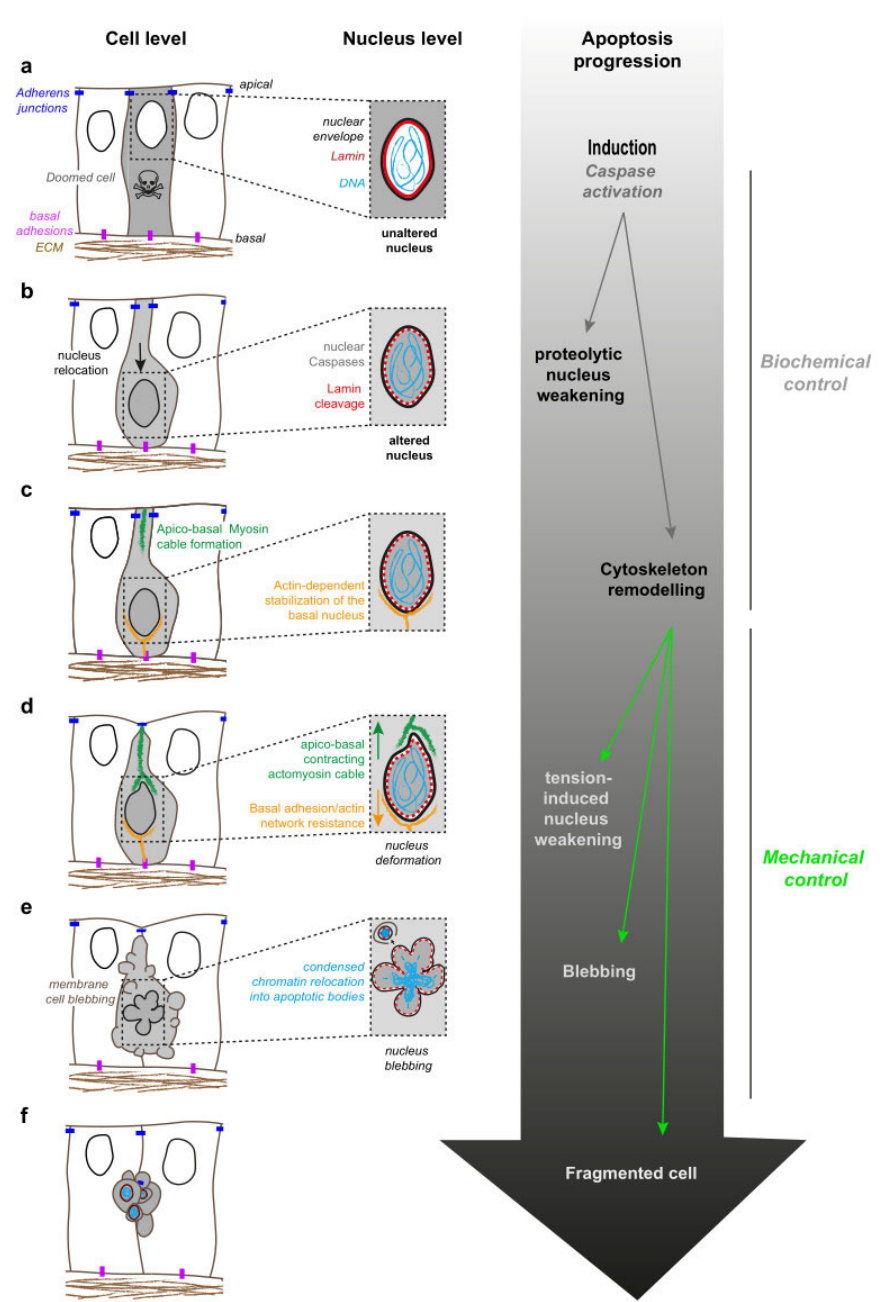
Figure 2. A model of biochemical and mechanical cooperation during apoptotic nucleus dismantling. Schematic representation of cell and nucleus dynamics (left and middle columns, respectively) gained from cells undergoing apoptosis in culture and in vivo. Contractile actomyosin structures are depicted in green, while non-contracting actin networks are shown in orange. Main steps driving nucleus dismantling are indicated on the right. Note that biochemical and mechanical aspects of apoptosis are represented subsequently for clarity, although proteolysis is not restricted to early stages of apoptosis. The main apoptotic stages are divided into caspase activation ( a ), nuclear relocation and apical constriction ( b ), nucleus basal anchoring and myosin II cable apical growth ( c ), myosin II cable/nucleus coupling, apico-basal force generation and nucleus deformation ( d ), cell and nucleus blebbing ( e ) and finally cell and nucleus fragmentation ( f